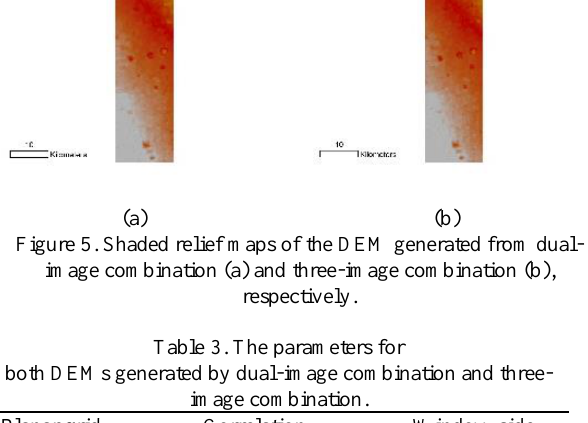
Figure 4. Comparison of the DEMs generated by different methds (a) PCI (b) a matching method based on triangle constraint (c) the object-space semi-global matching.